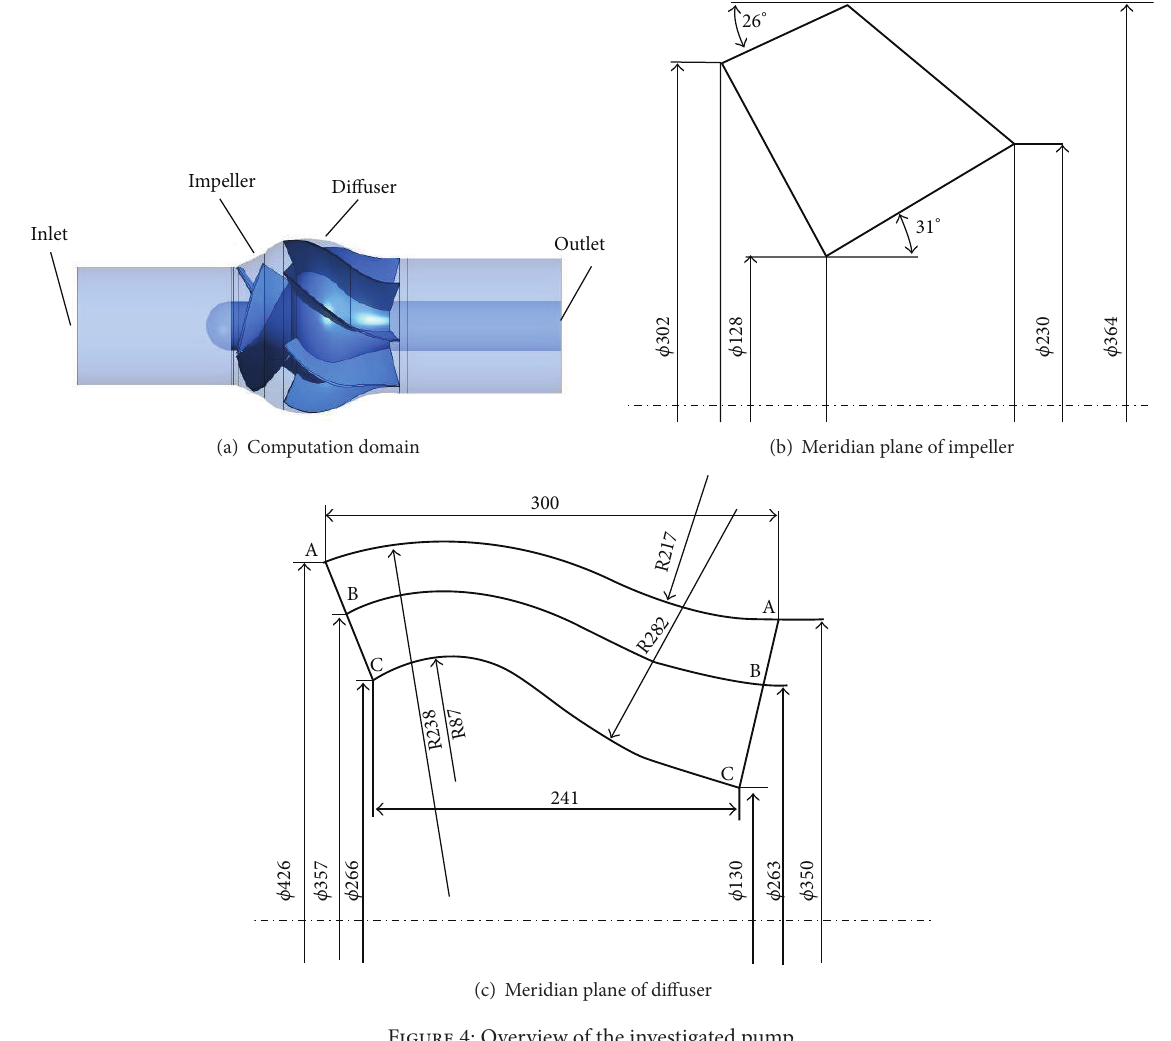
Figure 4: Overview of the investigated pump.